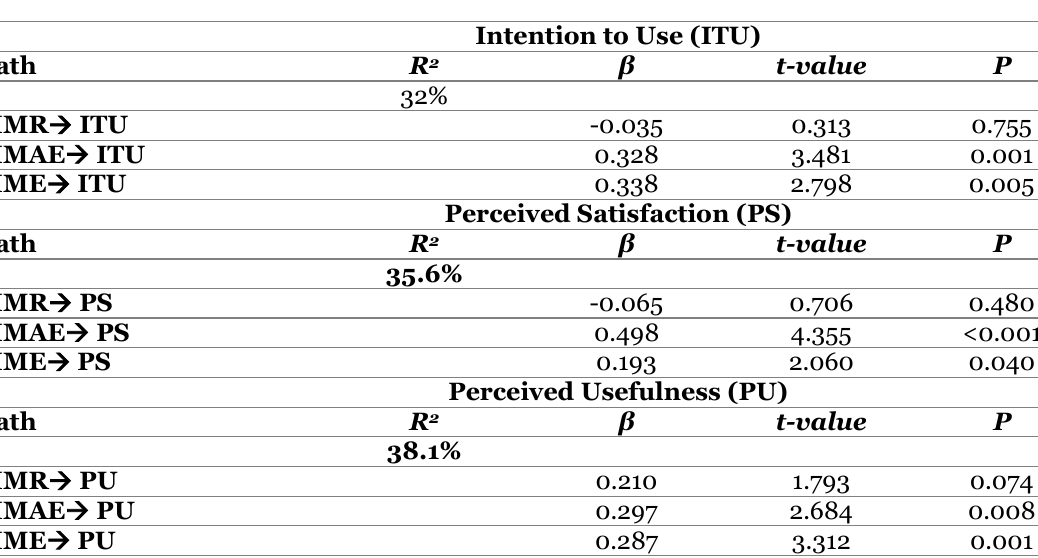
The Prediction Ability of UDL Principles on ITU, PS, and PU